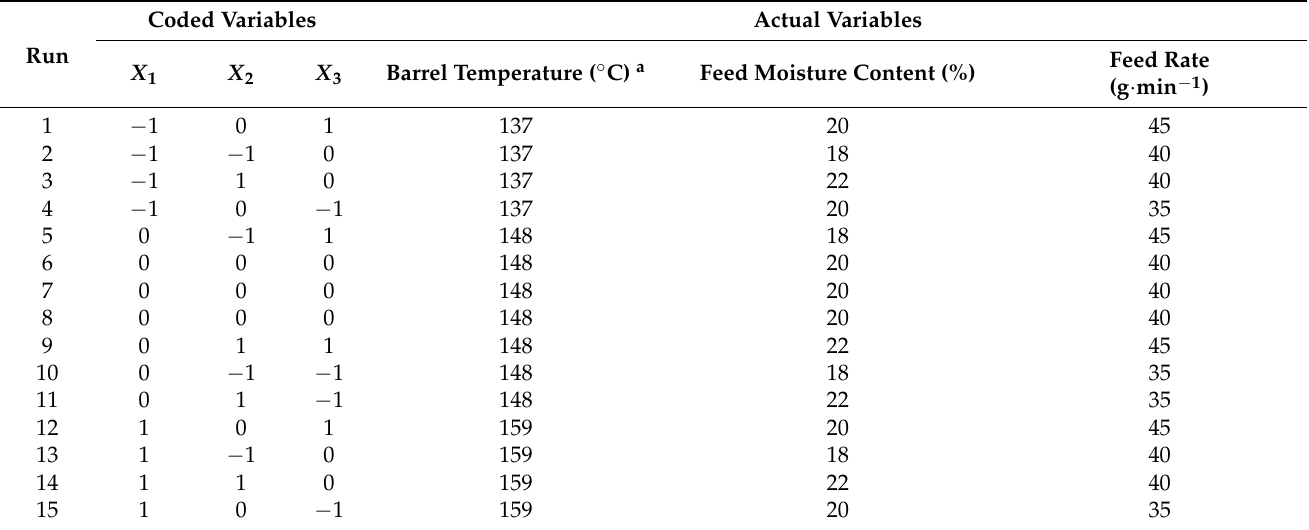
Table 2. Box–Behnken experimental design for extrusion of whole BGW